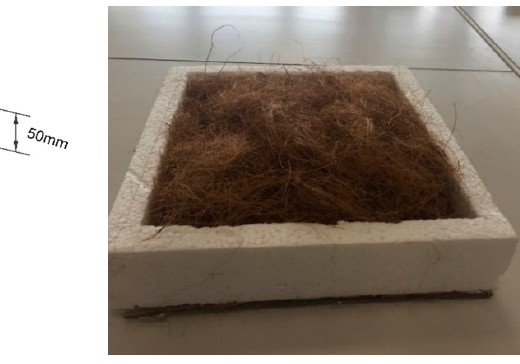
Figure 2. Test device for thermal conductivity, (Heat Flow Meter -HFM 436 Lambda).